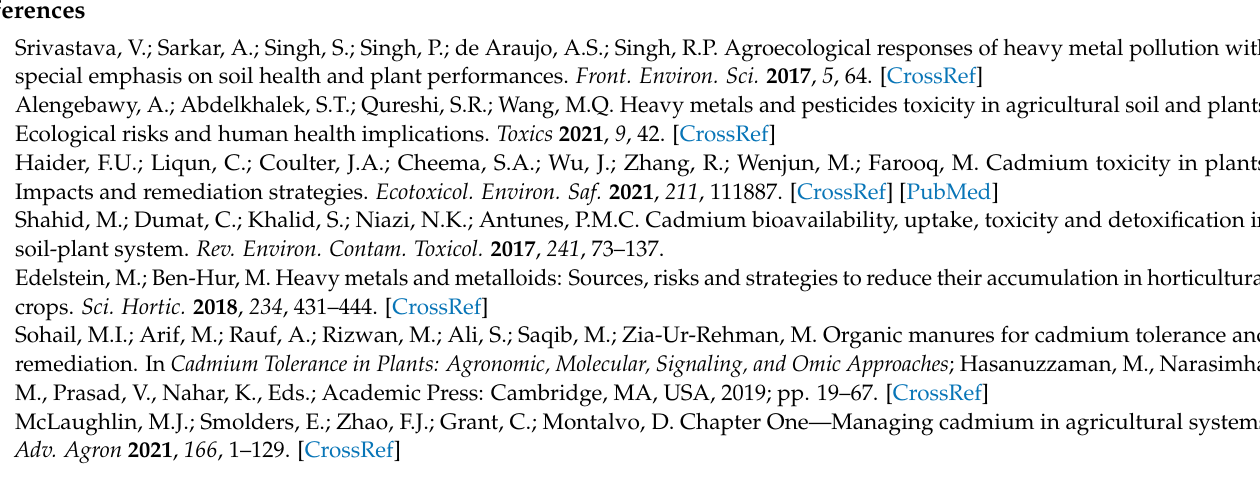
Figure A1. An unrooted, neighbor-joining (NJ) tree of the MTP family ( A ) and HMA family ( B ) in the selected plants. Branch lengths are proportional to phylogenetic distances.